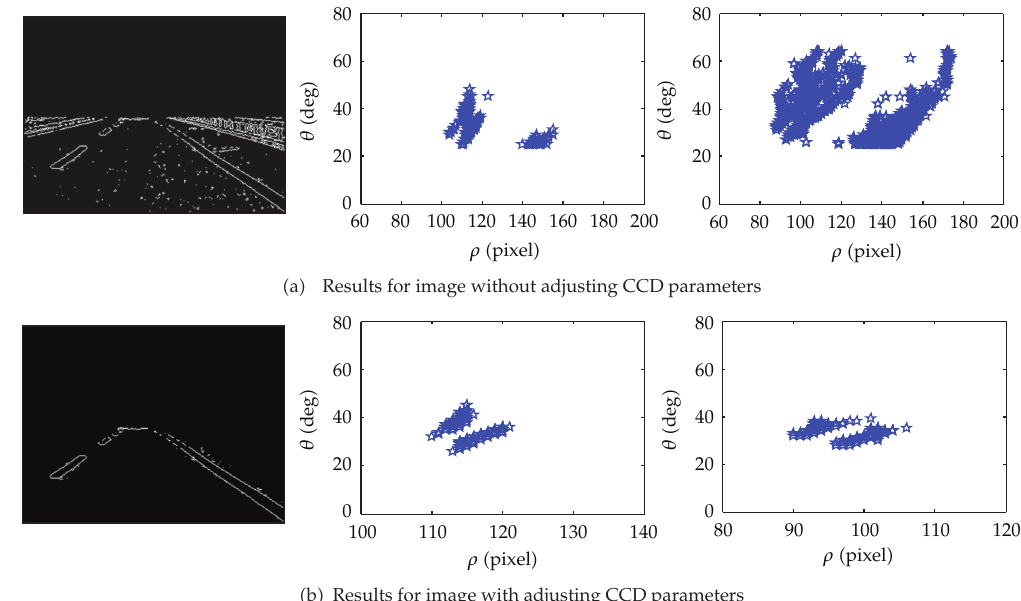
Figure 5: Peak value distributions for traditional Hough